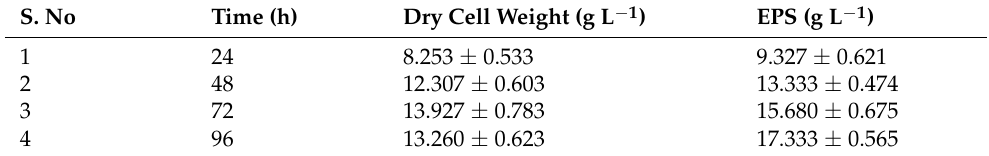
Table 1. Exopolysaccharide (EPS) production on Zobell marine broth by VITP14.